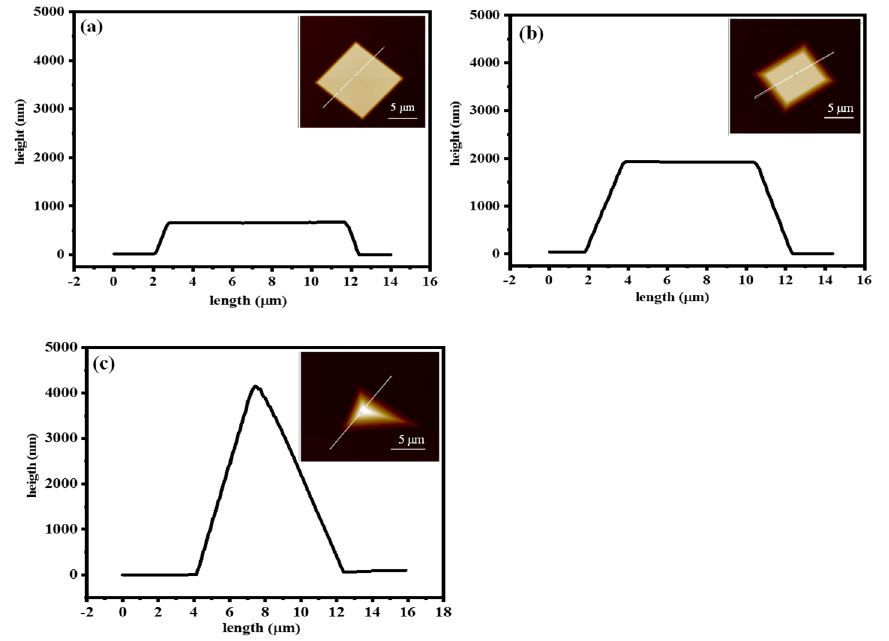
Figure 3. The AFM images and corresponding profile curves of the microplate ( a ), frustum of a square pyramid ( b ), and pyramid ( c